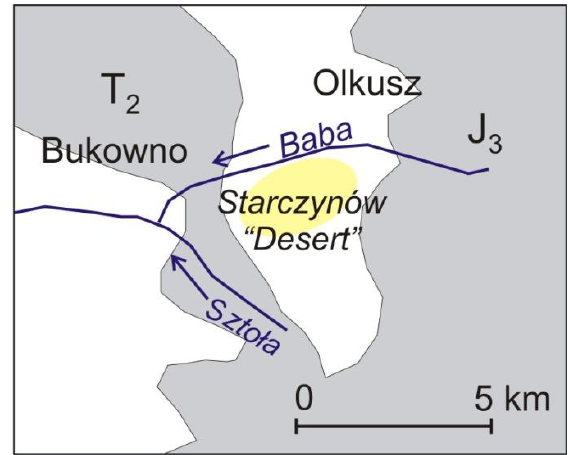
Fig. 1. Location of Starczynów „Desert”